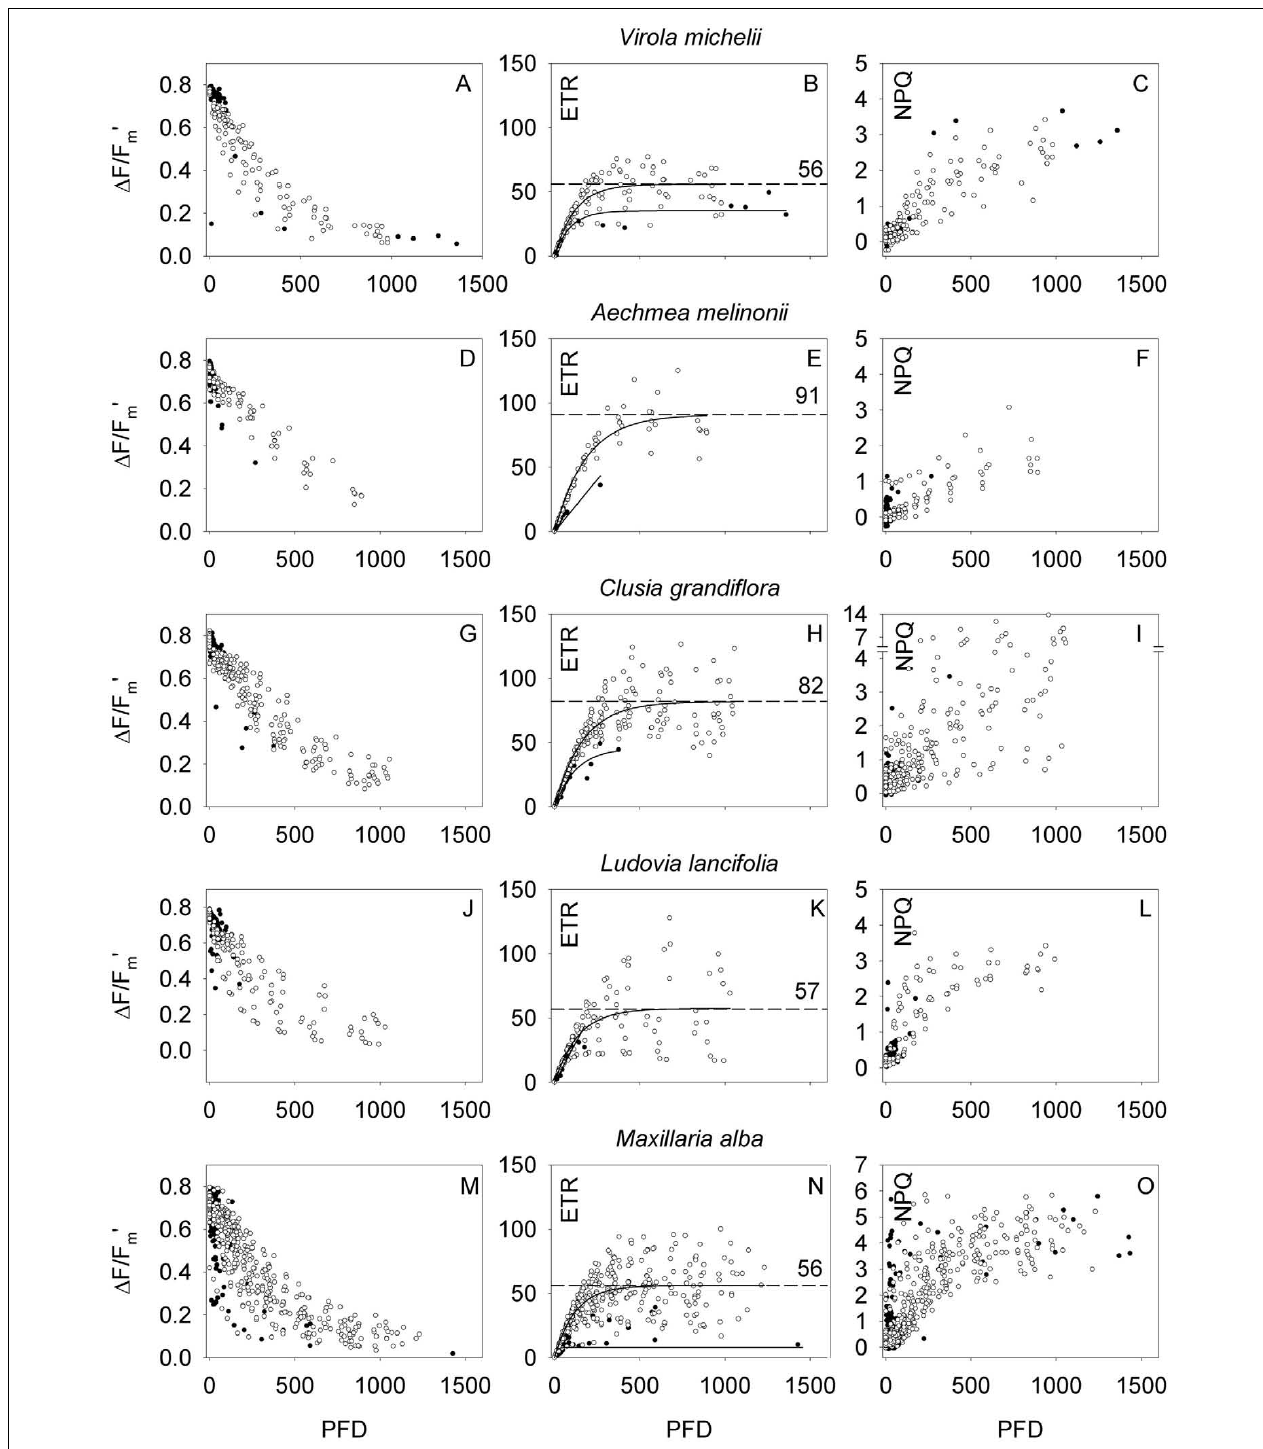
Maxillaria alba (M–O). Closed symbols refer to measurements under ambient PFD, while open symbols refer to instant light response curves with an adaptation time of 30s. ETR values were fitted using a single exponential function, the resulting best fitted function is shown in the graphs (solid lines: ETR max from ambient measurements, dashed lines, and numbers: ETR max from instant light response curves; ETR is given in micromole electrons m − 2 s − 1